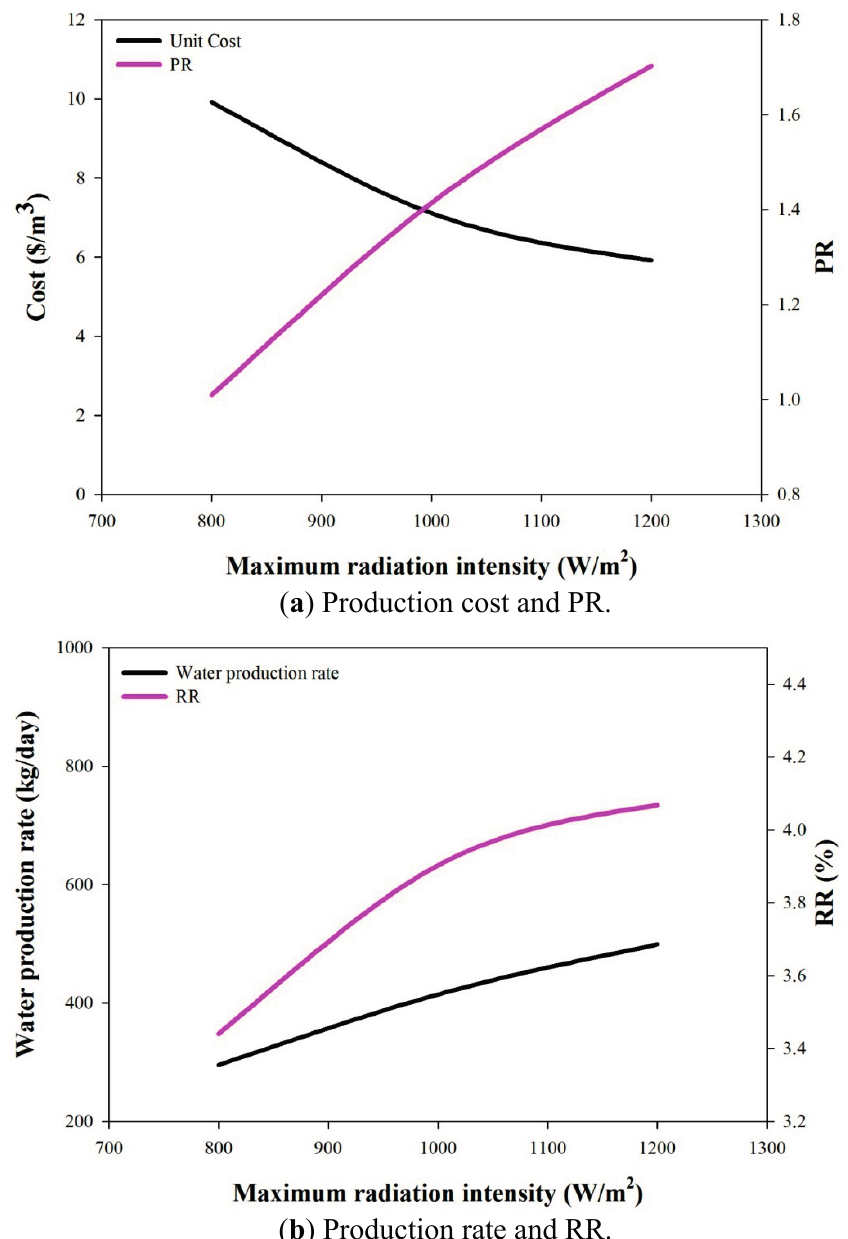
( b ) Production rate and